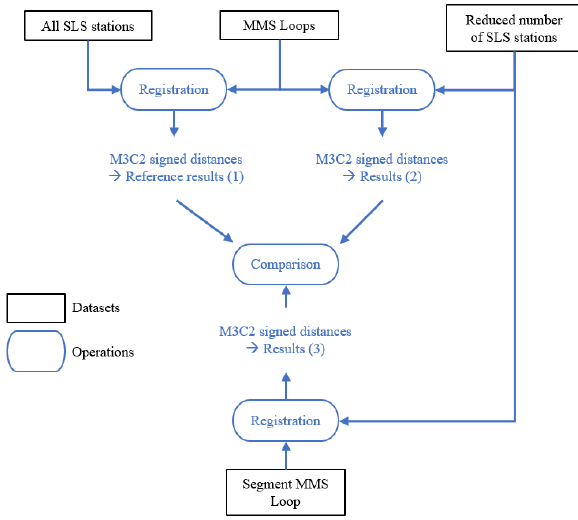
Figure 4 . Developed processing chain for the analysis of the combination of both systems.